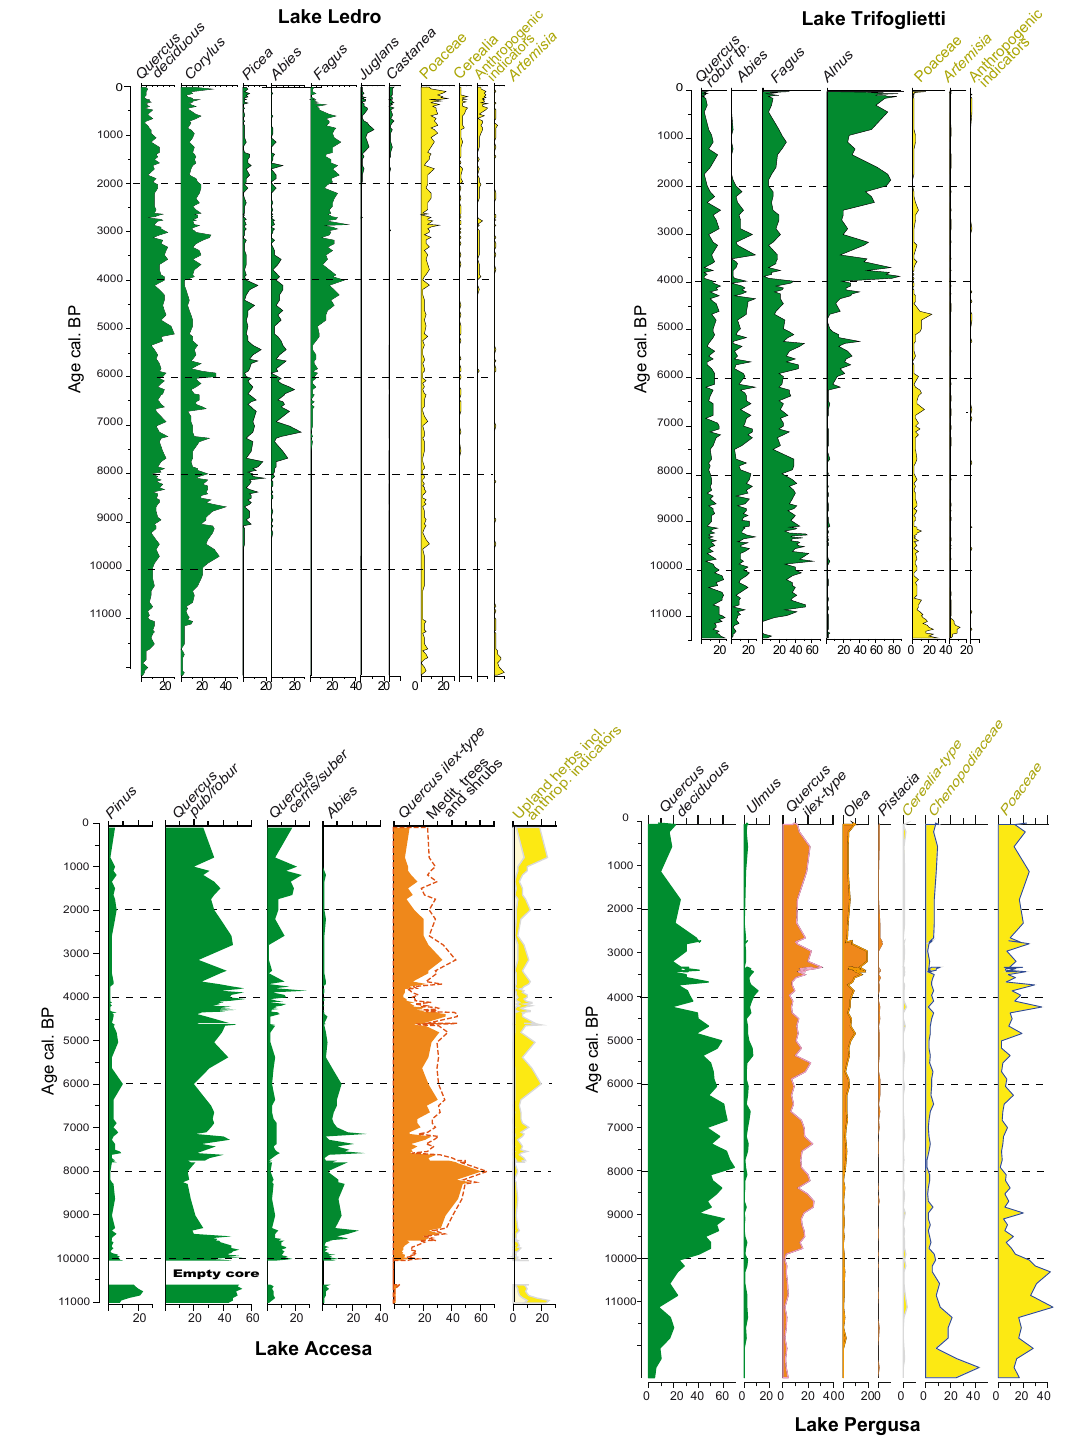
Fig. 2. Simplified pollen diagrams for the following: Lake Ledro deep core “LL081” (Joannin et al., 2013), Lake Accesa littoral core “AC3/4” (Drescher-Schneider et al., 2007), Lake Trifoglietti (Joannin et al., 2012) and Lake Pergusa (Sadori and Narcisi, 2001). The chronology of the four pollen records is based on radiocarbon dates compiled in Table 1. More details on each chronology are given in the references